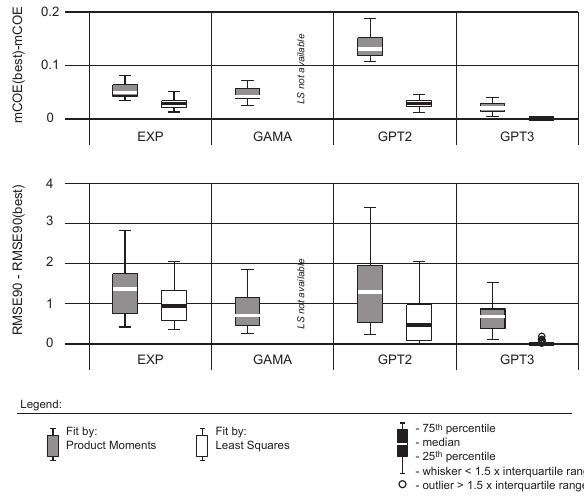
Fig. 8. Box plots showing the marginal error associated with choos- ing an alternate TDF and fitting method than the best available com- bination at each pluviograph. Error is very low for the GPT3/MLE combination as at most locations this combination exhibits the high- est fitting skill (therefore zero error). The upper box plot indicates the spread of error for mCOE and the lower plots error in RMSE90. The most attractive TDF and fitting method combinations are those displaying low values in both the upper and lower plots. Note that while outliers are identified above, this does not imply data was re- moved from any subsequent analysis.